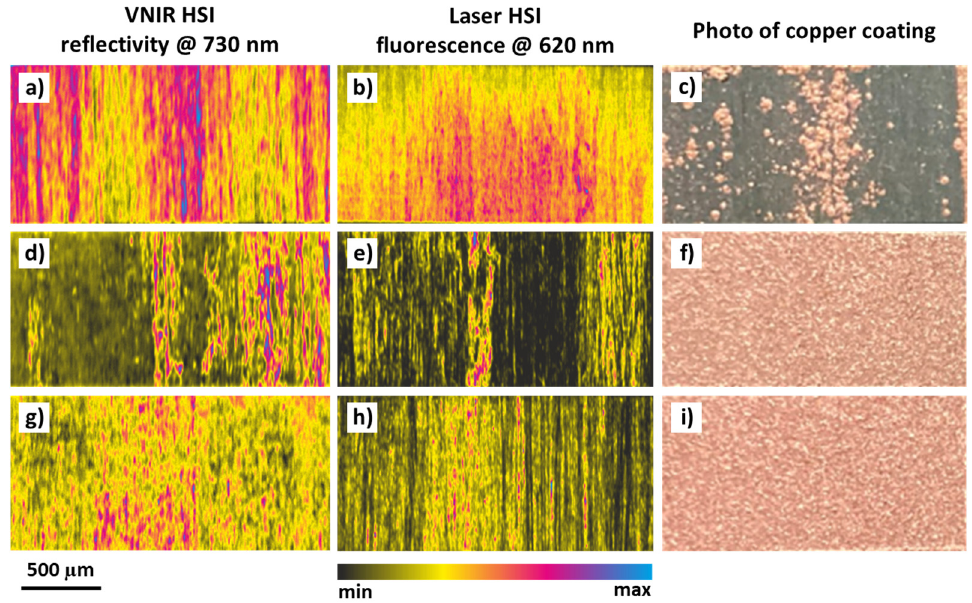
Figure 7. Comparison of hyperspectral measurements and copper coating adhesions (optical micro- graphs), for example, samples for each of the three sets of laser conditions used: ( a – c ) insufficient material removal, ( d – f ) optimal material removal, and ( g – i ) damaging material removal.